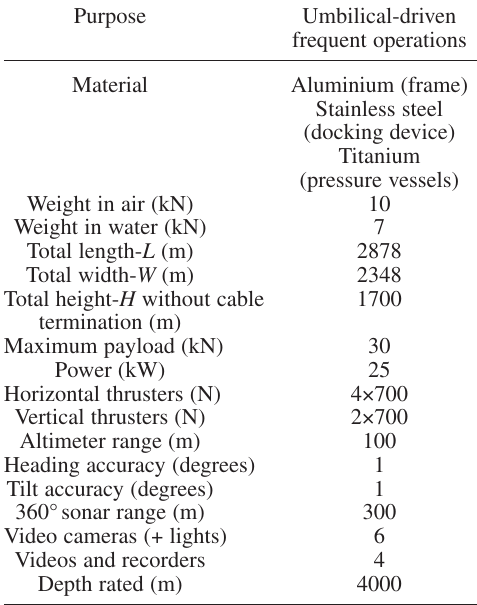
Table III. MODUS main characteristics (Clauss and Hoog, 2002; Clauss et al. , 2004; Gerber and Clauss,